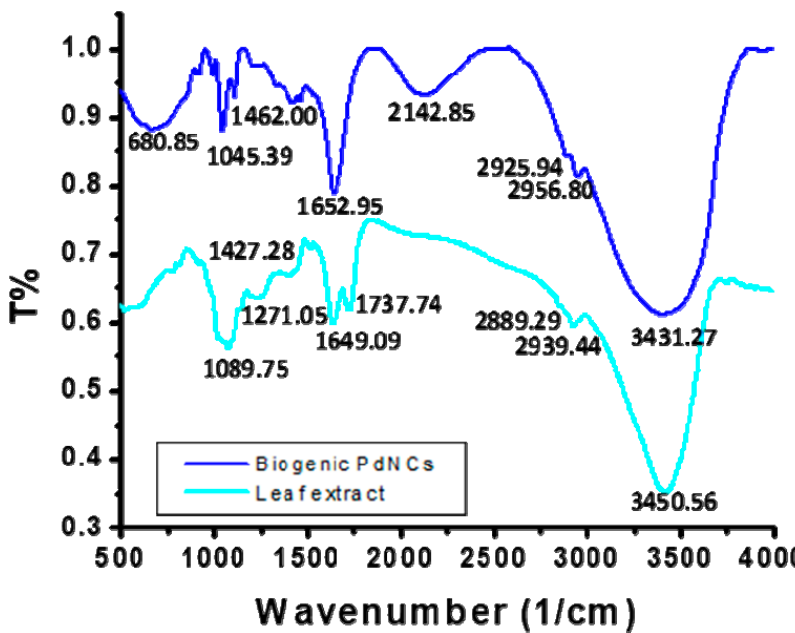
Figure 5. Fourier transform infrared (FTIR) spectra of the Erigeron Canadensis L. leaf extract and as-synthesized PdNCs.